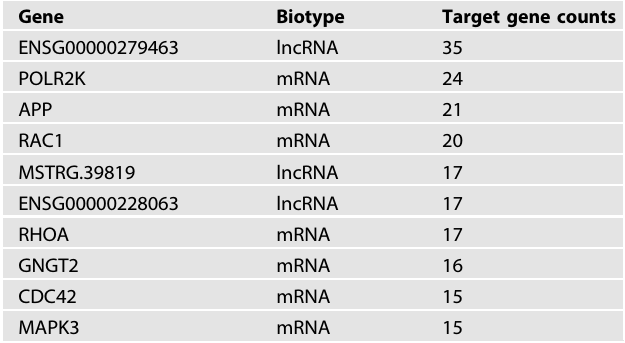
Table 3. The top 10 lncRNAs and mRNAs with numbers of related genes in co-expression